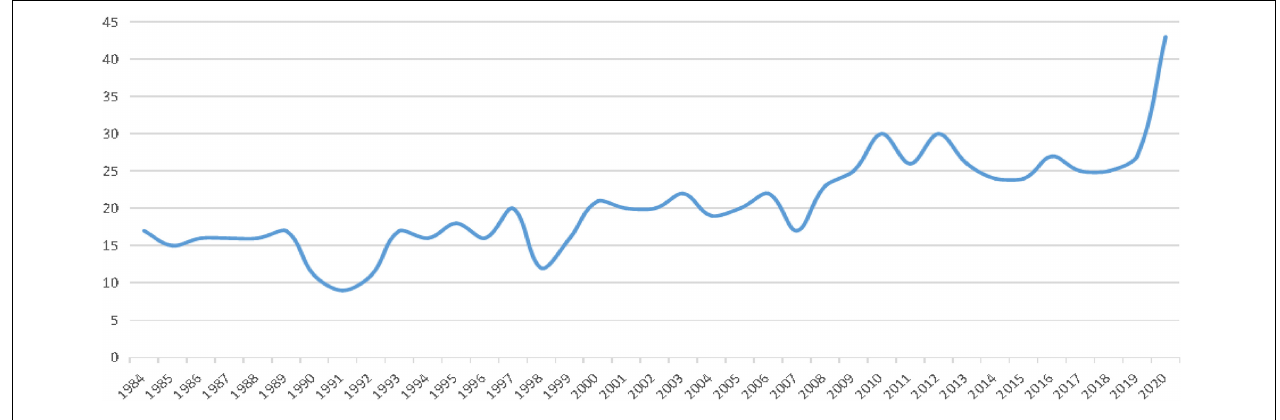
FIGURE 1 | Publications published in Language Testing from 1984 to